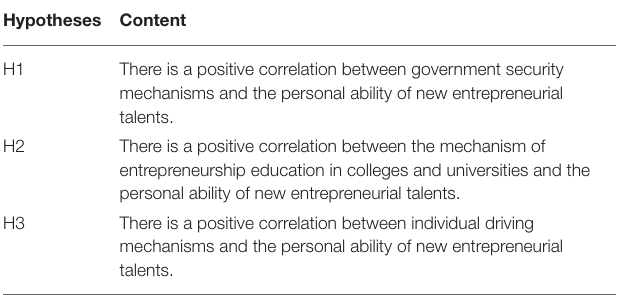
TABLE 4 | Hypotheses on the relationship between the qualities and the influencing factors of the entrepreneurial ability of new entrepreneurial talents. Hypotheses